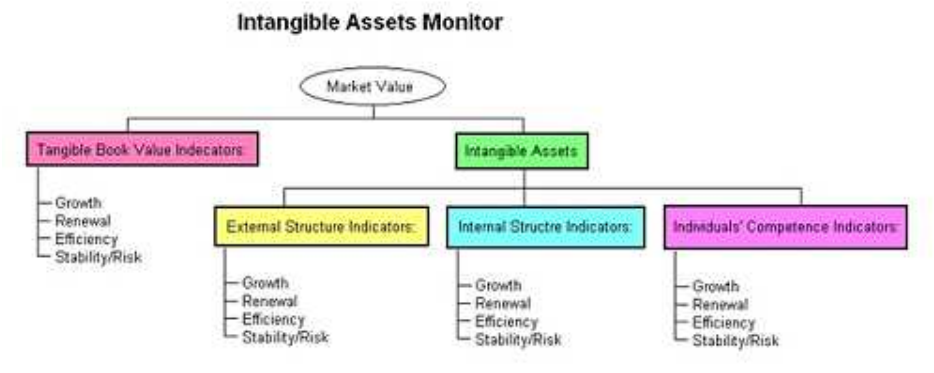
Figure 5 Intangible assets monitor (Source: Sveiby